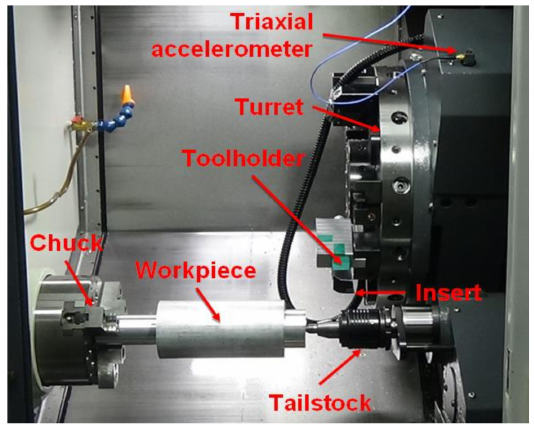
Figure 1. Installation architecture of lathe machining